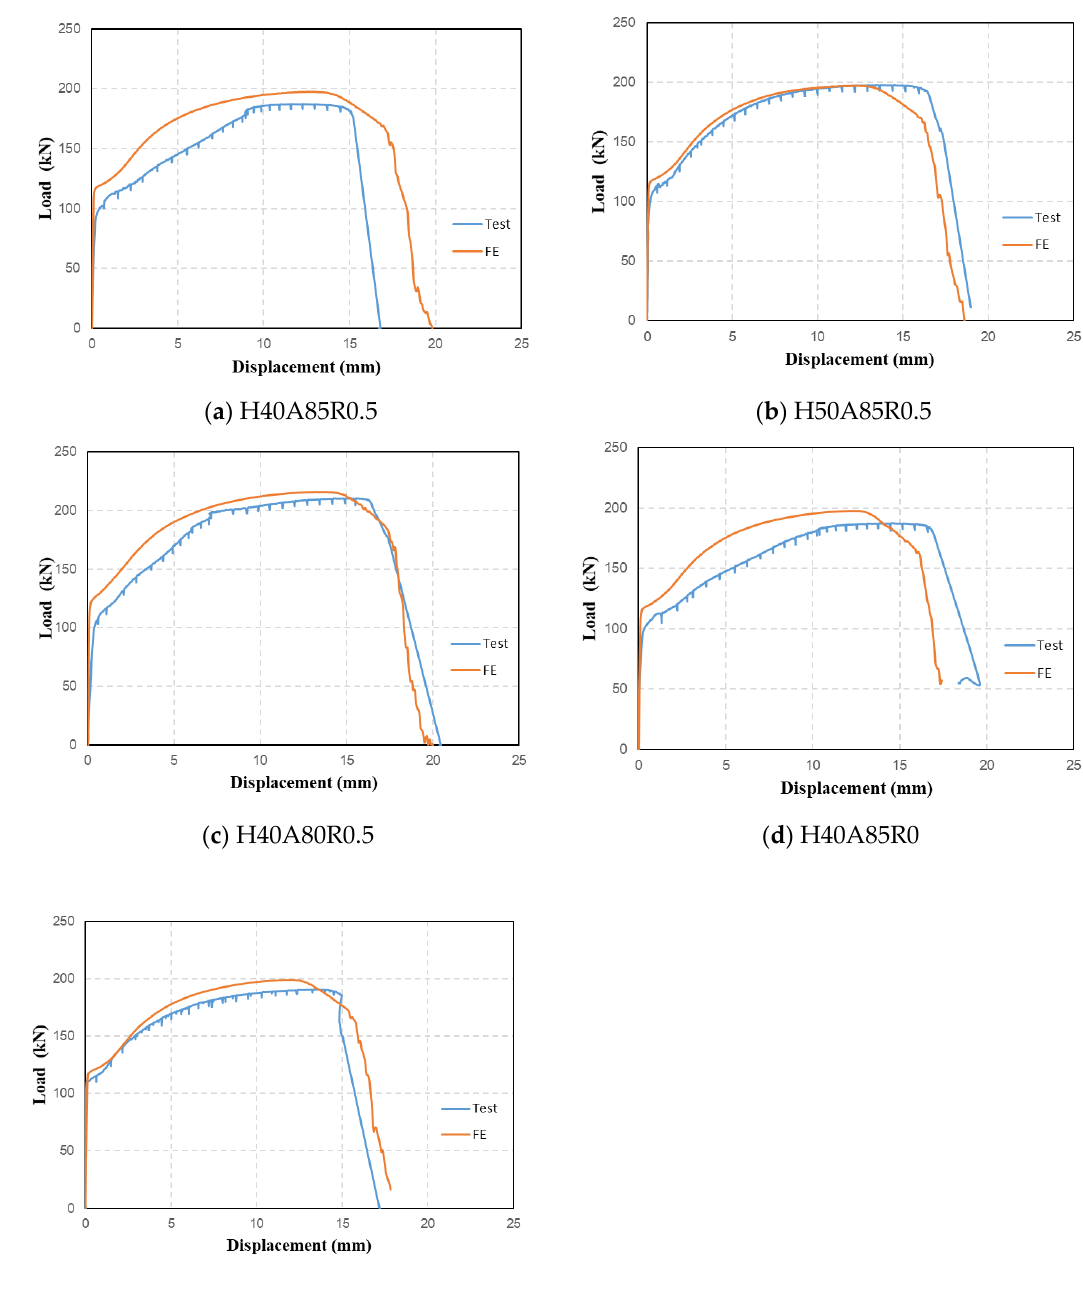
Figure 8. Comparison of failure modes with (a) H40A85R0.5,(b) H50A85R0.5, ( c ) H40A80R0.5, ( d ) H40A85R0 and ( e ) H40A85R1. 5. Discussions